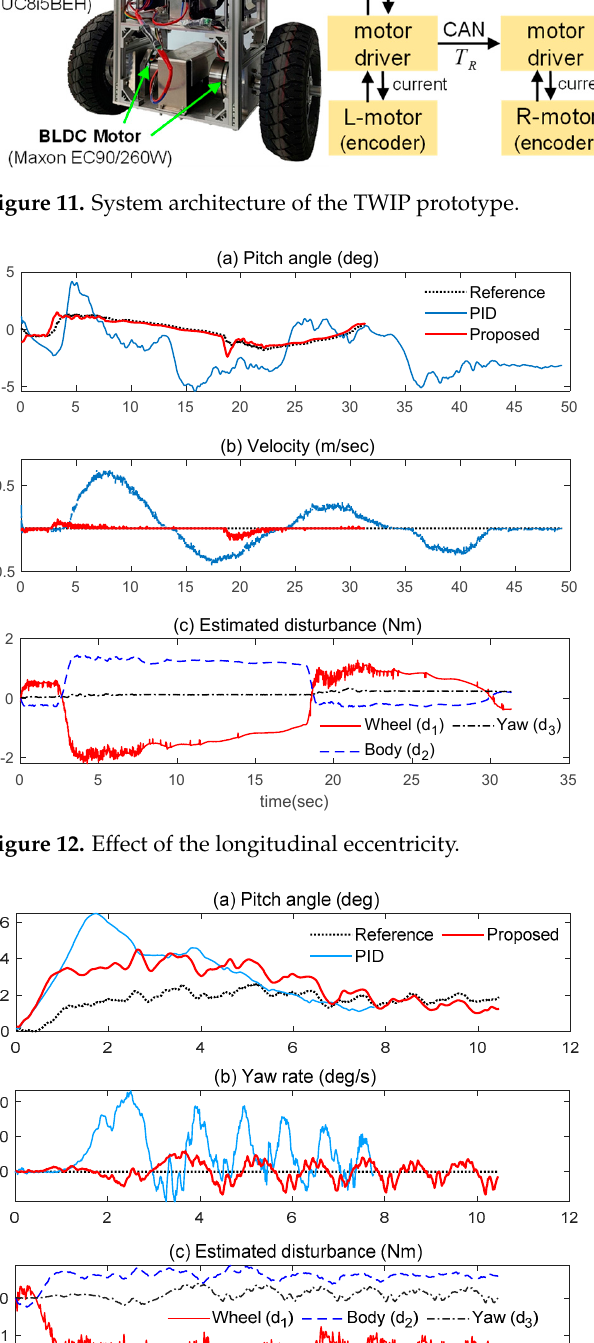
Figure 14. Effect of the terrain uncertainty during uphill driving.